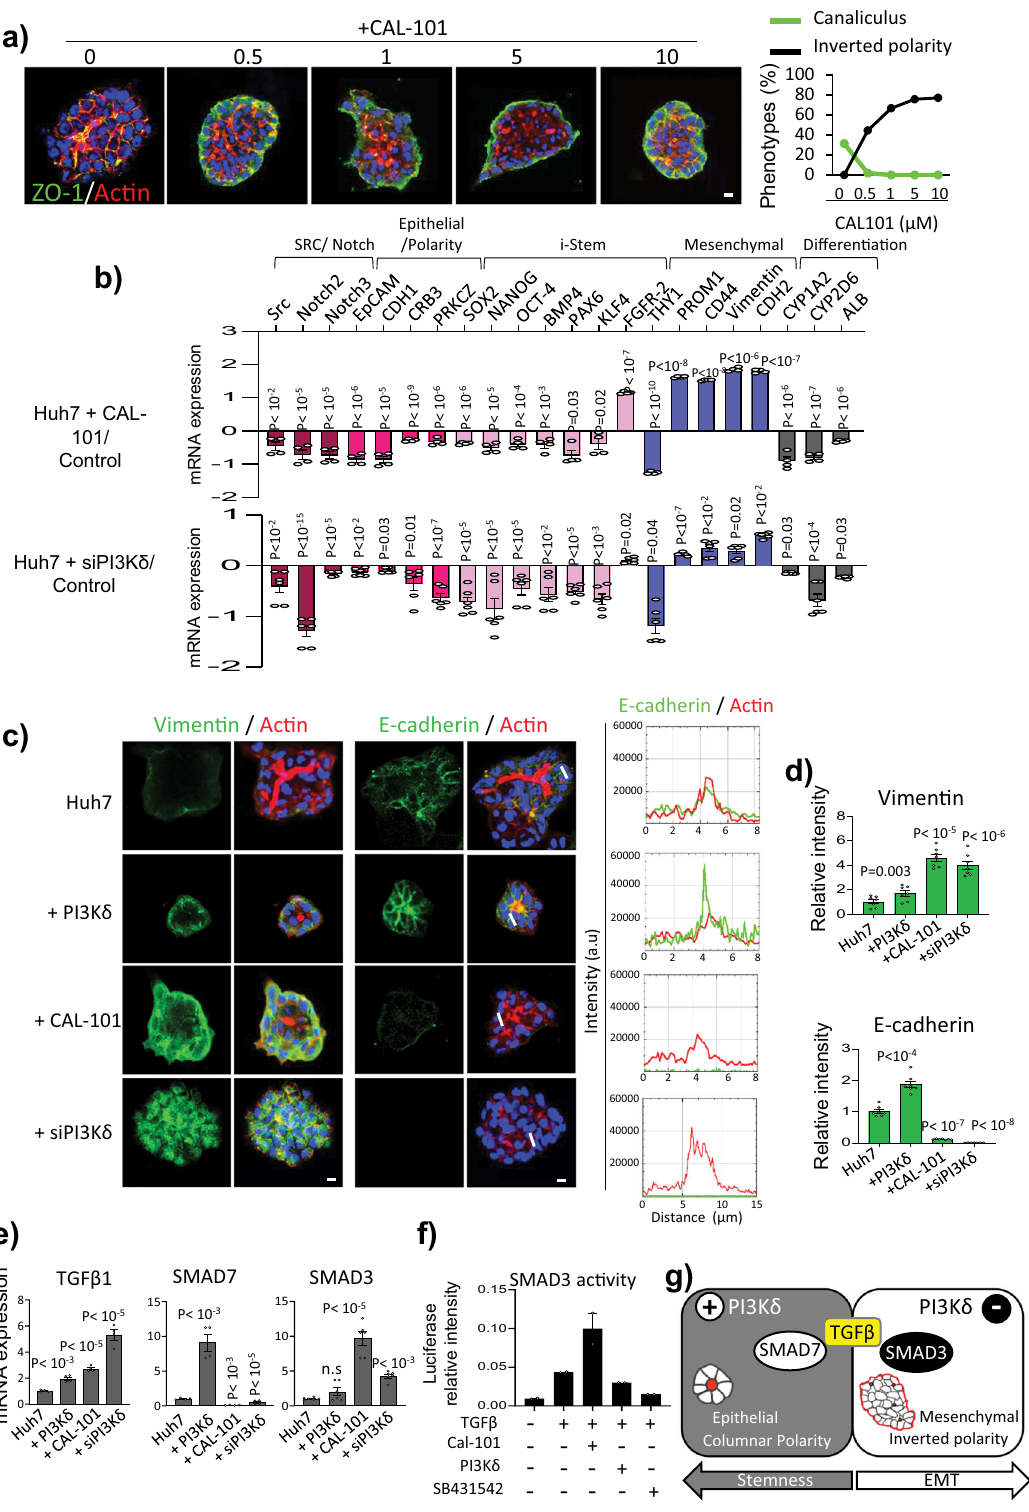
presence of DPBS, appropriate secondary antibodies coupled with peroxidase were manufacturer ’ s instructions. For 3D culture, 24h after the transfection, cells were added. Immunoblotting was revealed with chemiluminescent peroxidase substrate detached using trypsin and plated on Matrigel as indicated above. (Chemiluminescent Peroxidase Substrate-3; Sigma-Aldrich) and exposure was observed with G: box (Syngene). Immunoblot . Cells were lysed in Laemmli sample buffer and denatured at 100 °C for 5 min before separation on 10% SDS – PAGE and then electrotransferred onto Immuno fl uorescence staining . The cells were rinsed with ice-cold Dulbecco ’ s PBS nitrocellulose blotting membrane (Amersham Protran). After transfer, the mem- (DPBS) and fi xed with 4% paraformaldehyde for 20min at 4 °C. The samples were brane was saturated in DPBS containing 0.1% Tween 20 and 5% milk. Primary then permeabilized and saturated with DPBS supplemented with 0.7% fi sh gelatin antibodies (appropriate dilution) were added overnight at 4°C. After washes in the COMMUNICATIONS BIOLOGY| (2022) 5:740